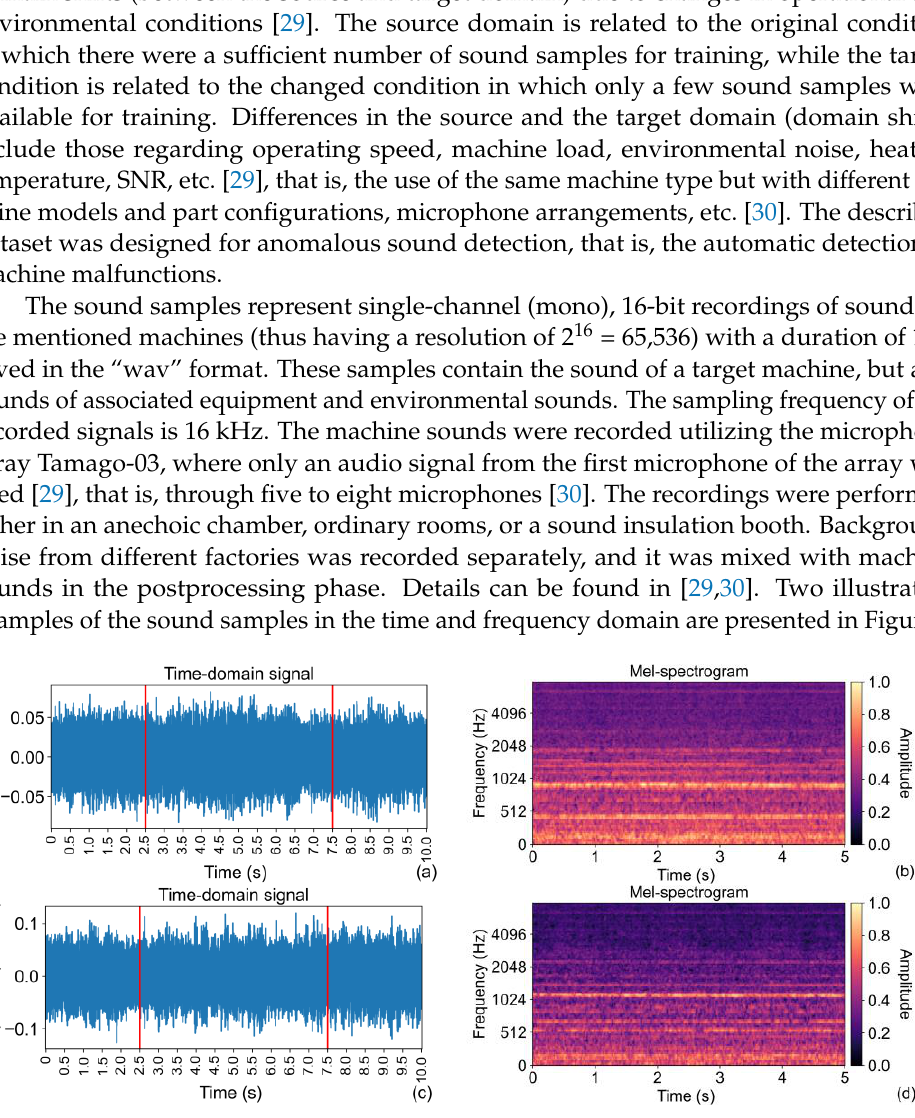
Figure 1. Sounds of two randomly chosen samples where the mid part of duration of 5 s — denoted by vertical lines — is extracted and mapped into mel-spectrogram: ( a ) time-domain signal and ( b ) mel-spectrogram of a sample from the slider class; ( c ) time-domain signal and ( d ) mel-spectrogram of a sample from the gearbox class.